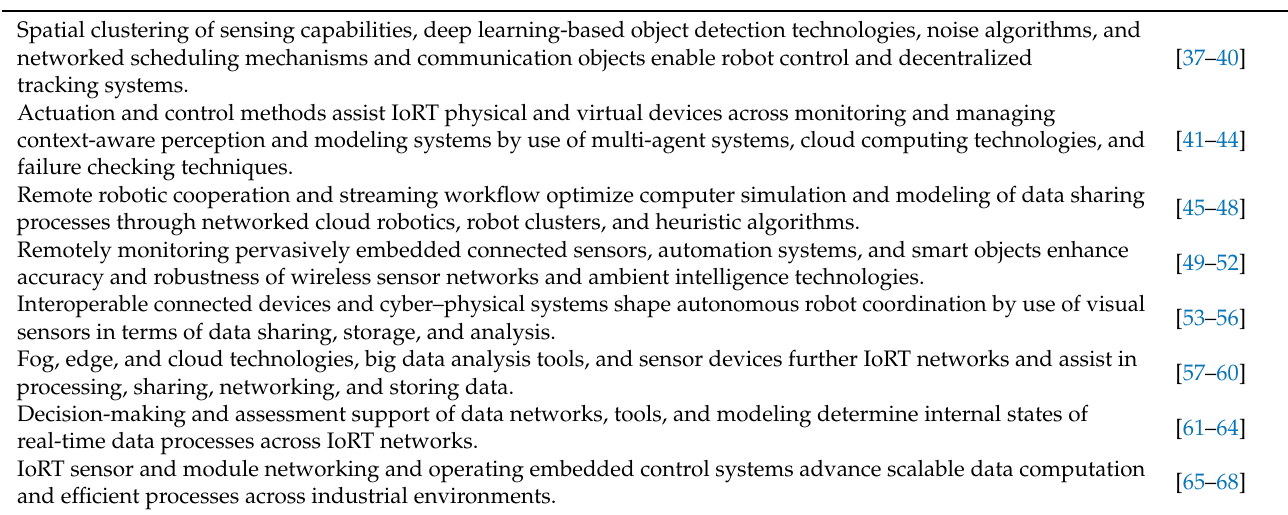
Table 4. Synopsis of evidence in relation to inspected topics and descriptive results (research